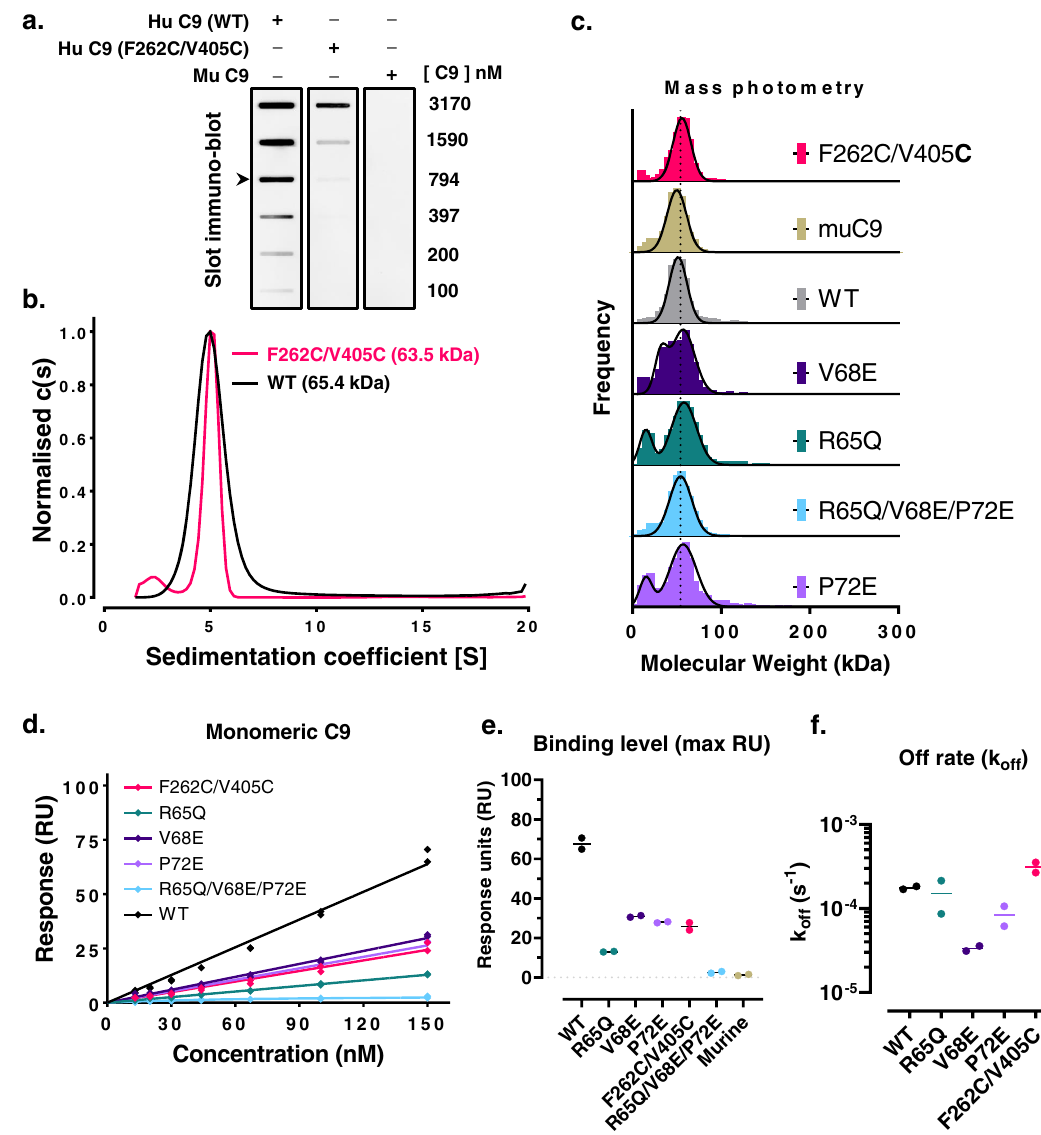
Fig. 4 Monomeric C9 is weakly recognised by aE11. a A concentration series of human, murine, and disulphide trapped C9 variants in the monomeric state detected by aE11 IgG in a slot immunoblot assay. An arrow shows the approximate physiological concentration of monomeric C9 (900 ± 200 nM) 59,60 . b Analytical ultracentrifugation of wild type and disulphide-trapped C9 at micromolar concentration shows only monomeric C9 species. c Mass photometry measurements of the molecular mass of C9 variants corroborates AUC measurements ( n = 2). Lower molecular weight peaks (~10 kDa) of R65Q and P72E variants correspond to a known contaminant. d Maximal SPR response of aE11 IgG binding versus concentration of monomeric C9 and variants ( n = 2). e Maximal binding of aE11 IgG to monomeric C9 at 150 nM ( n = 2). f Kinetic fi t of off-rate for one-to-one binding of aE11 IgG to monomeric C9 ( n = 2). Individual data points and their means are